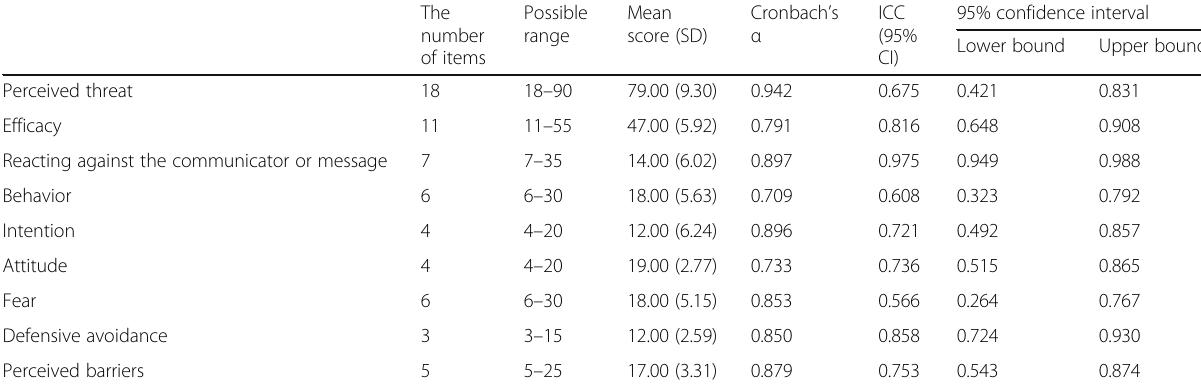
Table 2 The distributions and the main results based on the instrument among participants